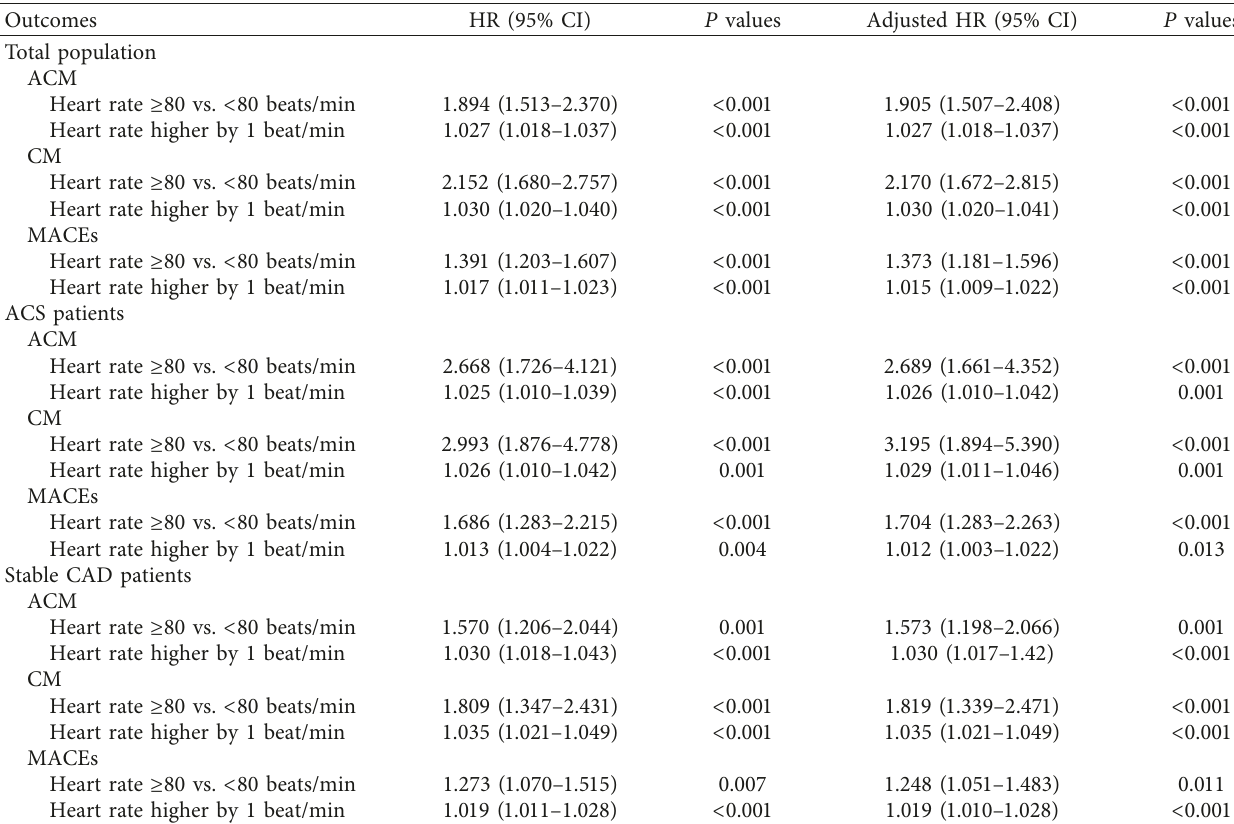
Table 6: Clinical outcomes and heart rate as continuous variable and